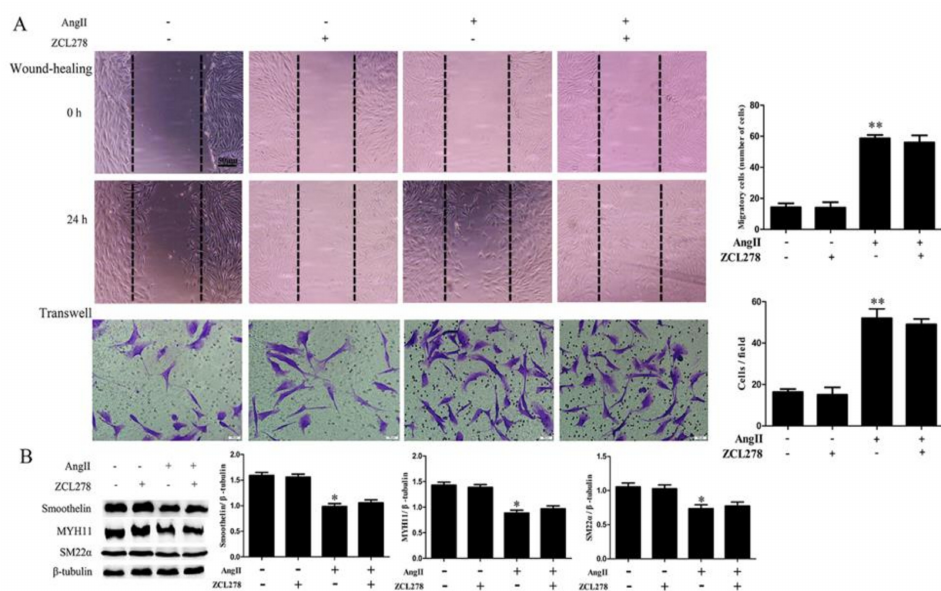
Figure 6. The e ff ects of Cdc42 inhibitor ZCL278 on cell migration and the expression of contractile marker proteins in HA-VSMCs. Cells were pretreated with ZCL278 (50 µ M) for 30 min and then exposed to 100 nM Ang II for 24 h. Untreated cells were used as the control. ( A ) Cell migration was detected by wound-healing and Transwell assays. Histograms show the quantification of the wound healing and Transwell assay results. The scar bar is 50 µ m. ** p < 0.01 vs. the control group ( n = 3). ( B ) Western blot analysis of MYH11, SM22 α , and smoothelin. Histograms show the ratios of MYH11 or SM22 α or smoothelin to β -tubulin. * p < 0.05 vs. the control group ( n =